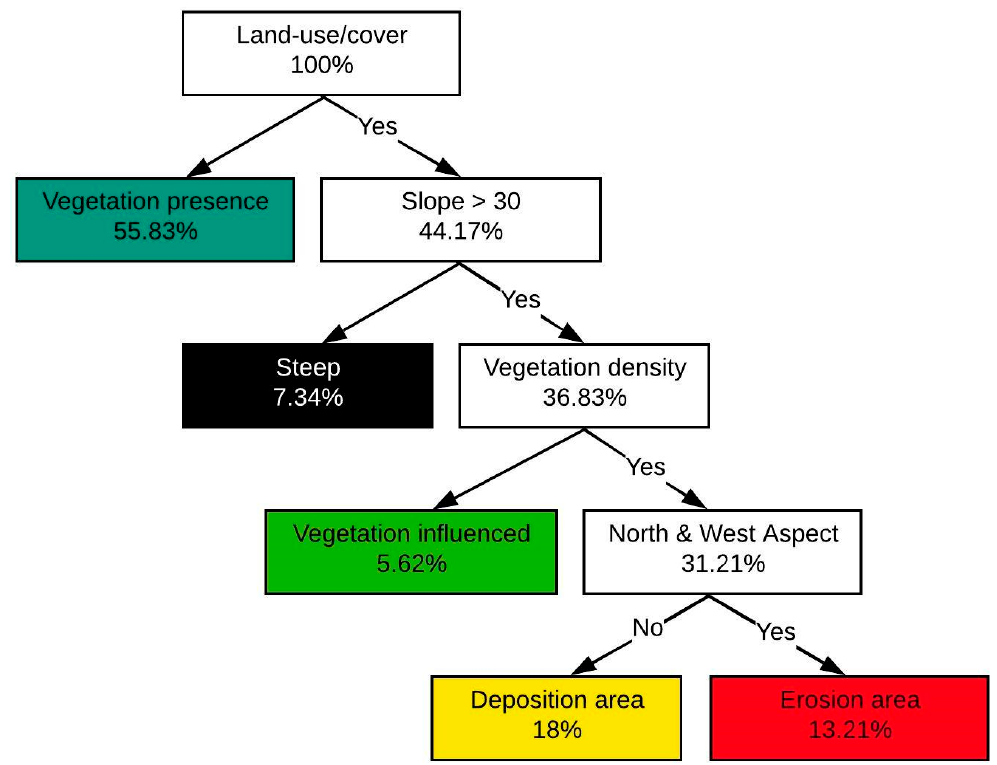
Figure 4. Outline of the decision tree diagram to display the deposition and erosion areas of the study area at the Friends of the Dunes. The color codes in the terminal node match with Figure 6.